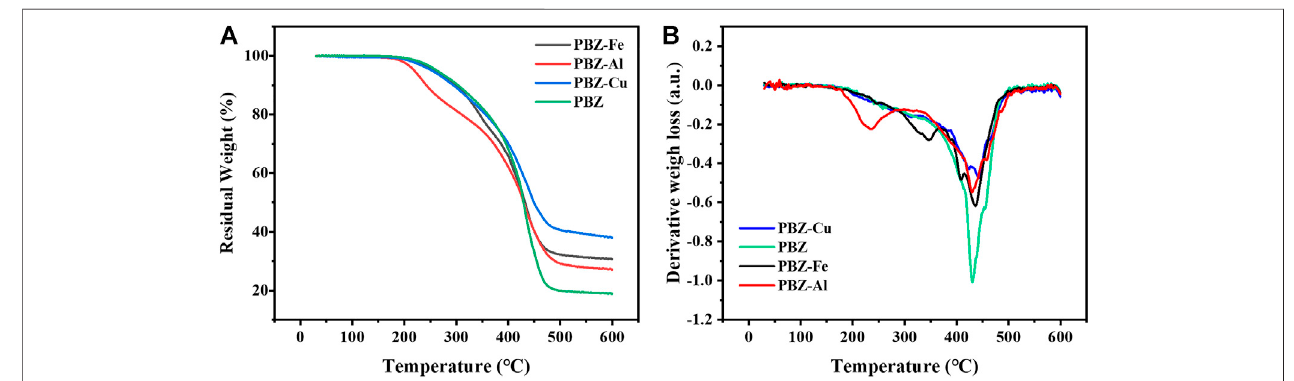
FIGURE 6 | TGA traces (A) and DTA curve (B) of the PBZ-M.